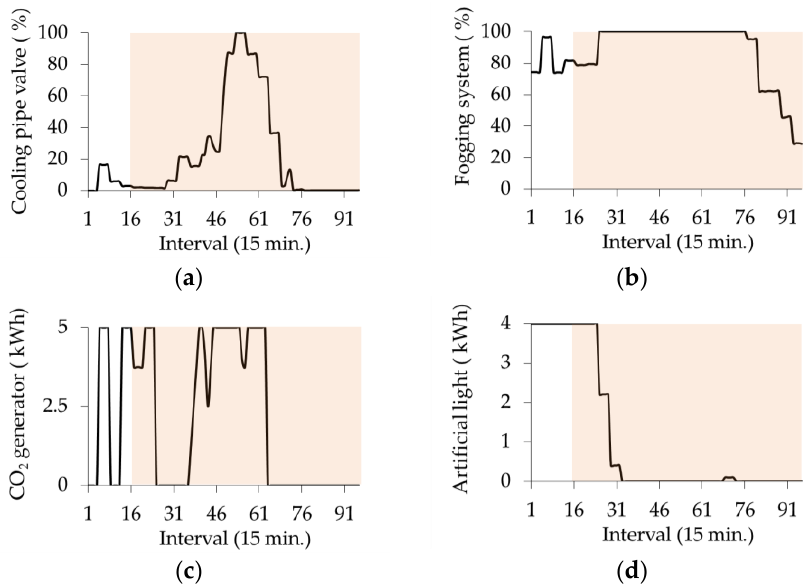
Figure 7. Environmental control of a building microgrid with rooftop greenhouse: ( a ) Temperature; ( b ) Humidity; ( c ) CO 2 concentration; ( d ) Light intensity.